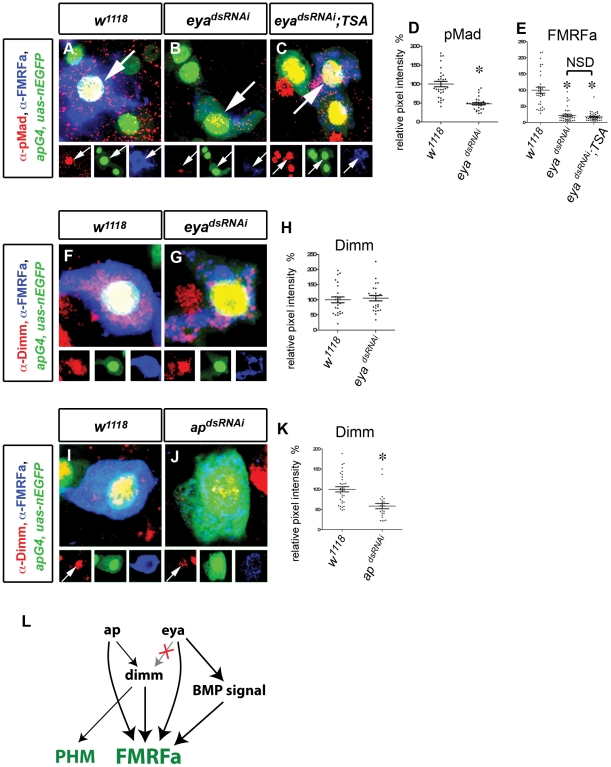
Changes in Tv4 network configuration for maintenance.(A–E) eya regulates FMRFa independently of BMP signaling. (A,B) Nuclear pMad accumulation (red) in Tv4 (arrowhead) was downregulated in eyadsRNAi flies (B) compared to w1118 control (A). (C) Expression of eyadsRNAi in the presence of constitutively-activated Thickveins and Saxophone BMP type I receptors (TSA) activated pMad accumulation (red) in all Tv neurons (including Tv4; arrow) but failed to rescue FMRFa (blue) compared to w1118 control. (D) Quantification of pMad immunoreactivity in Tv4 nucleus in w1118 and eyadsRNAi flies. * p<0.0001 eyadsRNAi (n = 30) compared to w1118 control (n = 30). (E) Quantification of FMRFa immunoreactivity in Tv4 in w1118, eyadsRNAi and eyadsRNAi; TSA. * p<0.0001 eyadsRNAi (n = 38) and eyadsRNAi; TSA (n = 42) compared to w1118 control (n = 34). NSD, no significant difference between eyadsRNAi and eyadsRNAi; TSA. (F–H) eya does not regulate dimm in adult Tv4. dimm (red) in Tv neurons (blue) is maintained in eyadsRNAi (G) compared to w1118 control (F). (H) Quantification of Dimm immunoreactivity in Tv4. There is no significant difference between eyadsRNAi (n = 24) and w1118 (n = 25) controls (p = 0.67). (I–K) ap regulates dimm in adult Tv4. dimm (red) in Tv neurons (blue) is downregulated in apdsRNAi (J) compared to w1118 control (I). (K) Quantification of Dimm immunoreactivity in Tv4. * p<0.0001 apdsRNAi (n = 24) compared to w1118 (n = 35). (L) Model depicting regulatory configuration of ap, eya, dimm and BMP signaling from embryonic to adult Tv4. The dependence of dimm on eya expression is not maintained (X). Genotypes: w1118 (A,D, F,H, I,J) (UAS-dicer2/+; apGal4/+; tub-Gal80TS, UAS-nEGFP/+); eyadsRNAi flies (B,D,E, G,H) (UAS-dicer2/UAS-eyadsRNAi; apGal4/+; tub-Gal80TS, UAS-nEGFP/+); eyadsRNAi; TSA flies (C,E) (UAS-dicer2/UAS-eyadsRNAi; apGal4/UAS-tkvA, UAS-saxA; tub-Gal80TS, UAS-nEGFP/+). apdsRNAi flies (J),K (UAS-dicer2/+; apGal4; tub-Gal80TS, UAS-nEGFP/UAS-apdsRNAi).